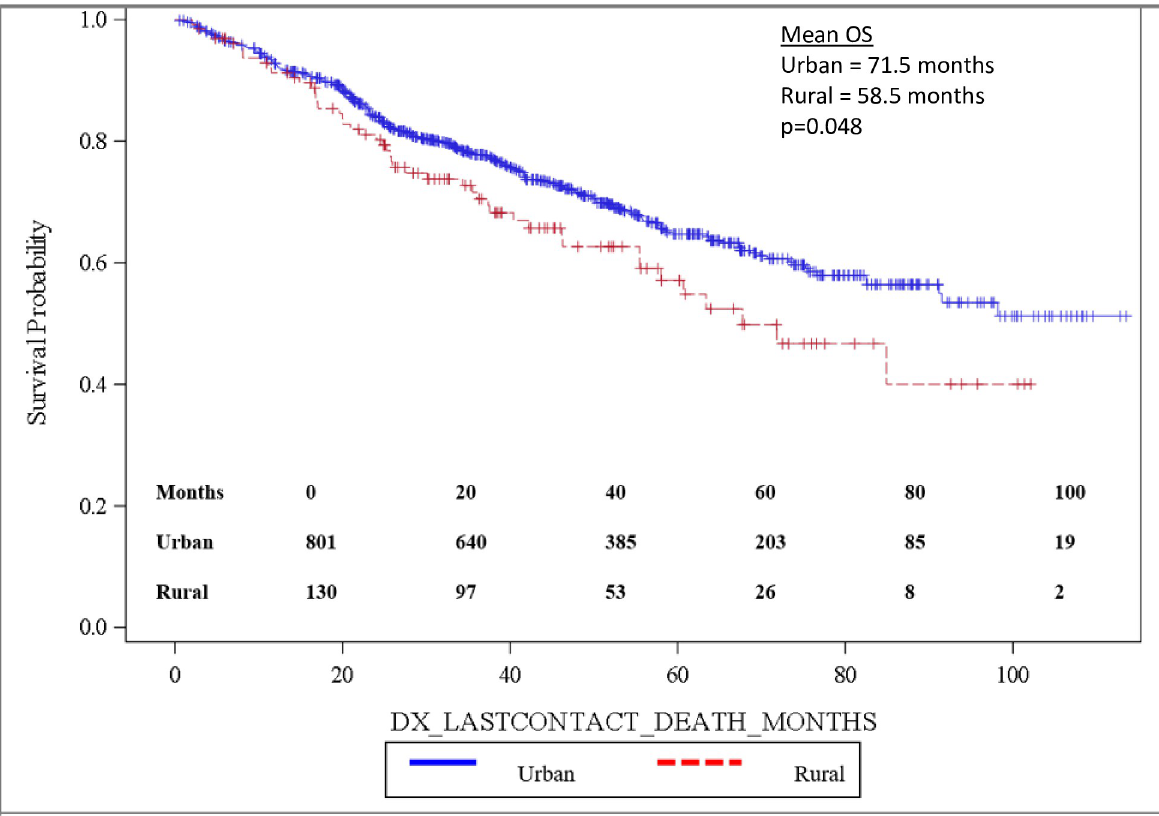
Fig 3. Overall survival by residential